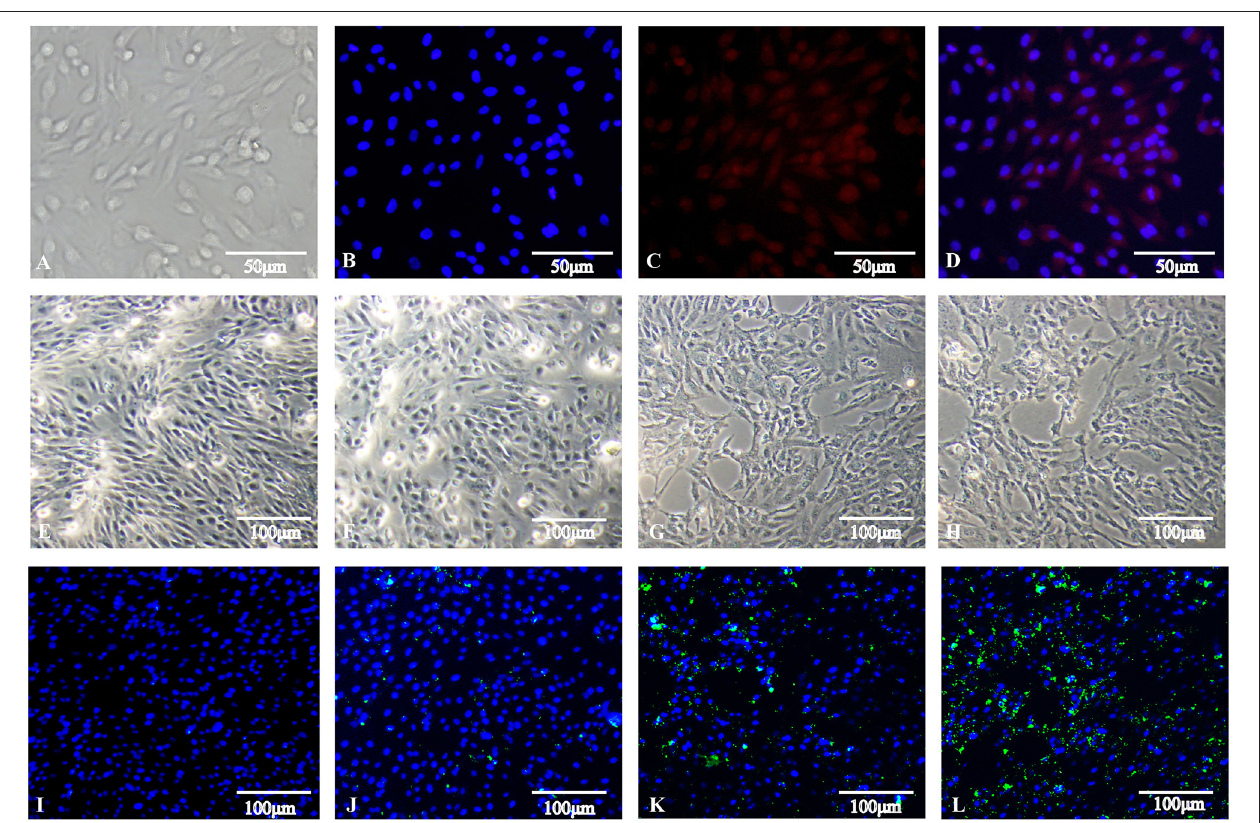
FIGURE 1 | Isolation of duck granulosa cells and challenge with Salmonella Enteritidis MY1 strain. (A–D) Isolation and identification of duck granulosa cells. (A) Diagram of a duck granulosa cell (400 × ); (B) DAPI staining of cell nucleus; (C) Fluorescent image of FSHR; (D) Stacking chart of (B,C) . (E–L) dGCs morphology changes and the number of invasive SE at different times post-infection. Phase-contrast microscopy of dGCs infected at an MOI of 10 at 0 hpi (E) , 3 hpi (F) , 6 hpi (G) , and 9 hpi (H) , respectively. Indirect immunofluorescent staining and DAPI staining of dGCs infected at an MOI of 10 at 0 hpi (I) , 3 hpi (J) , 6 hpi (K) , and 9 hpi (L) , respectively.